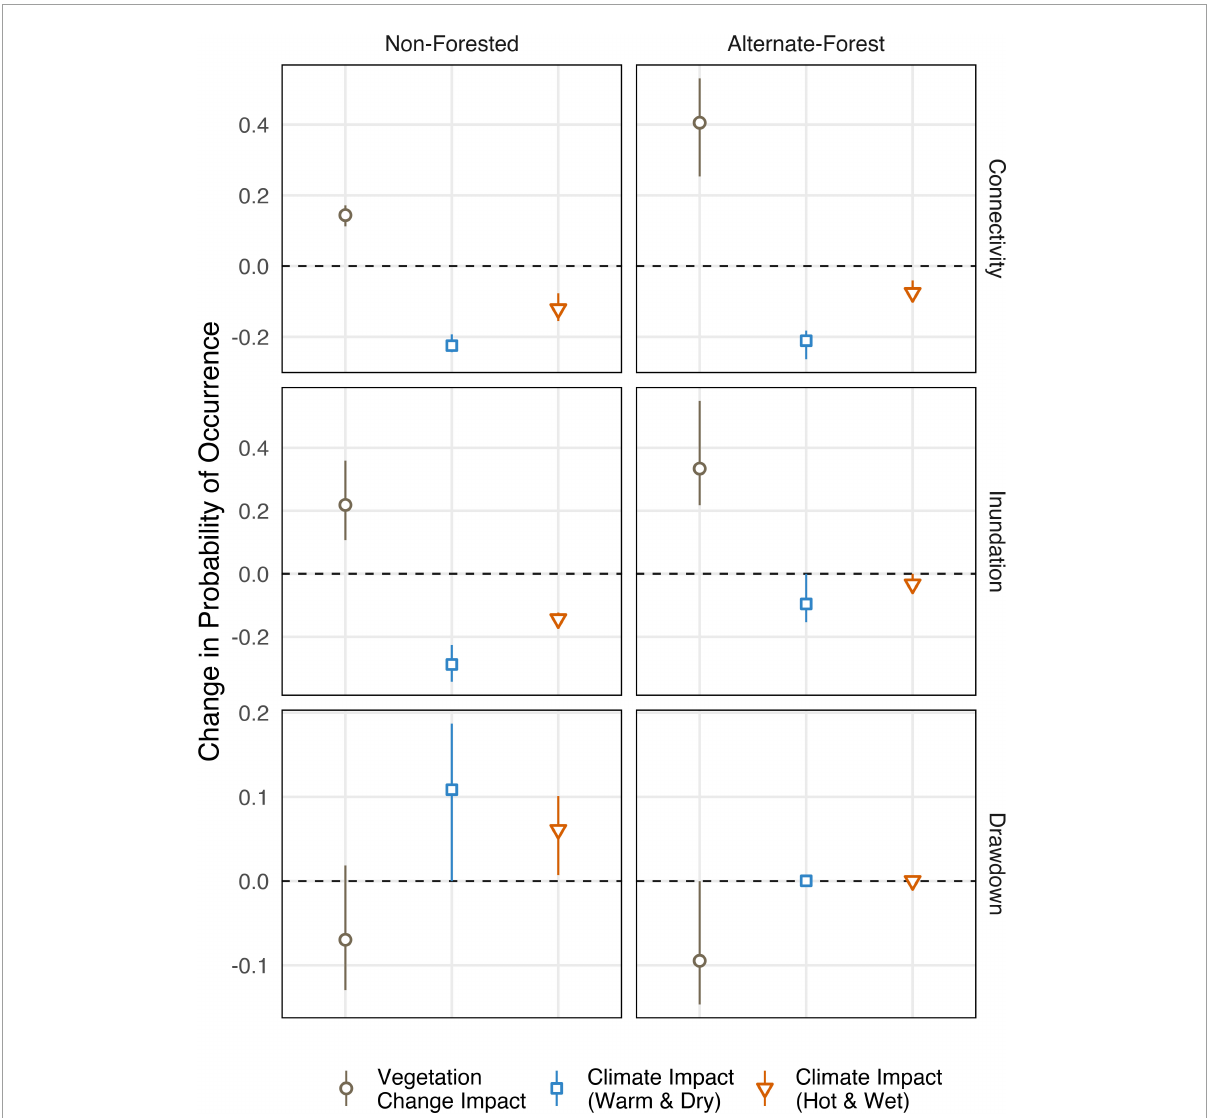
FIGURE8 Expected change in probability of occurrence for critical ecohydrological water levels that can be attributed to future climate scenarios or vegetation change due to emerald ash borer (EAB) impact and management response. Vegetation impact values represent the difference between simulated black ash forests and each alternative vegetative condition under current climate conditions. Climate impacts represent the difference between each alternative vegetative condition under the current climate and future climate (warm & dry or hot & wet) scenarios. Differences are calculated using the daily values from July through September, highlighting growing season impacts. Values are reported as the median (point) and the bounds of a 67% highest density continuous interval (HDCI, an interval, potentially asymmetric, that contains 67% of simulated values). For some combination of vegetation conditions and climate scenarios the HDCI may be indistinguishable from the point